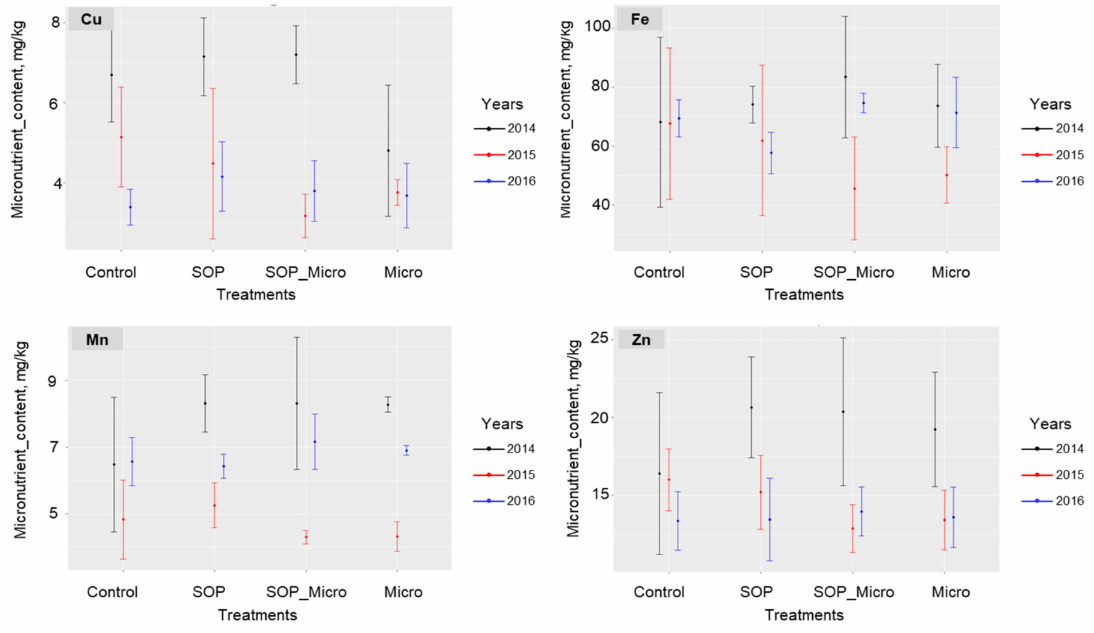
Figure 4. E ff ect of foliar fertilization with potassium and micronutrients on micronutrient content in potato tubers in the variety Hermes at the stage in full